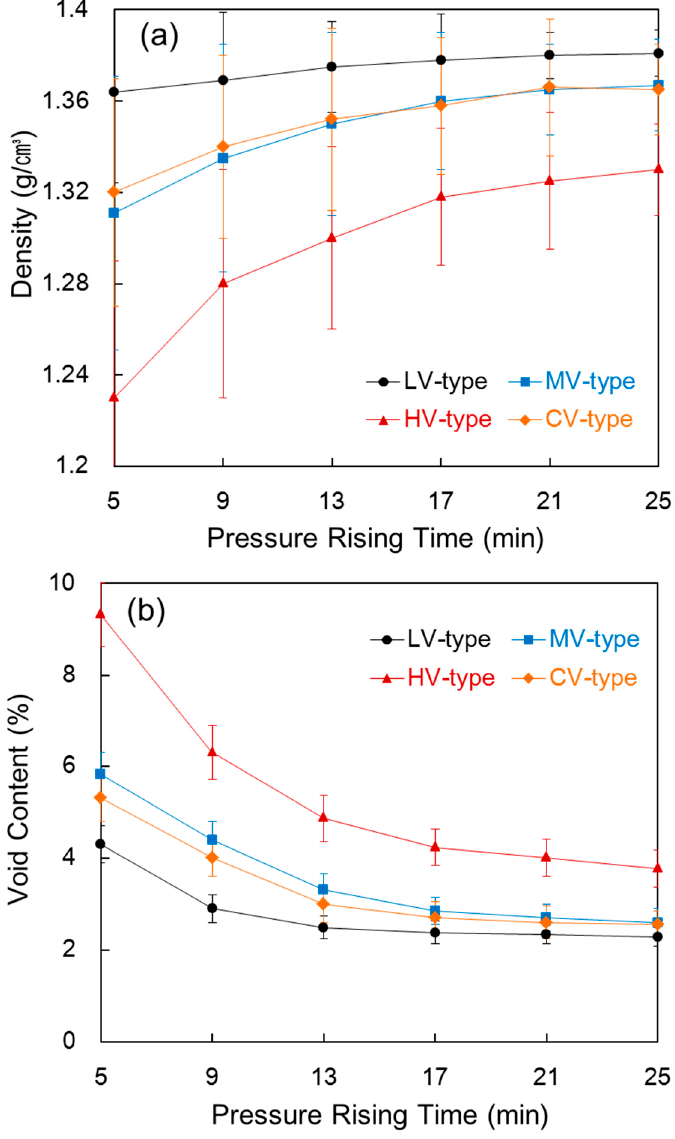
Figure 3. Density ( a ) and void content ( b ) of the composite compared with the pressure rising time in each film stacking type.